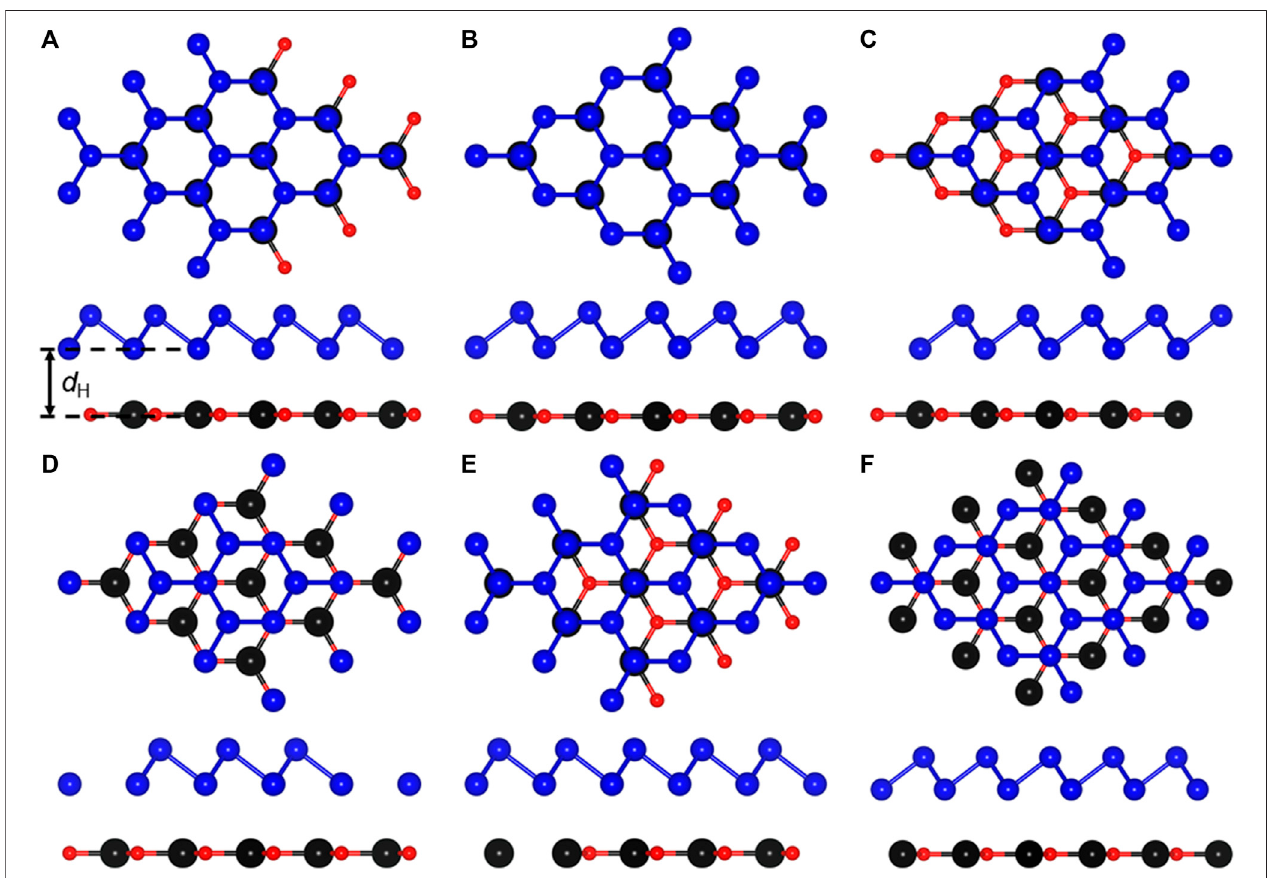
FIGURE 2 | The CdO/As heterostructure constructing by (A) CA 1 , (B) CA 2 , (C) CA 3 , (D) CA 4 , (E) CA 5 and (F) CA 6 con fi gurations.